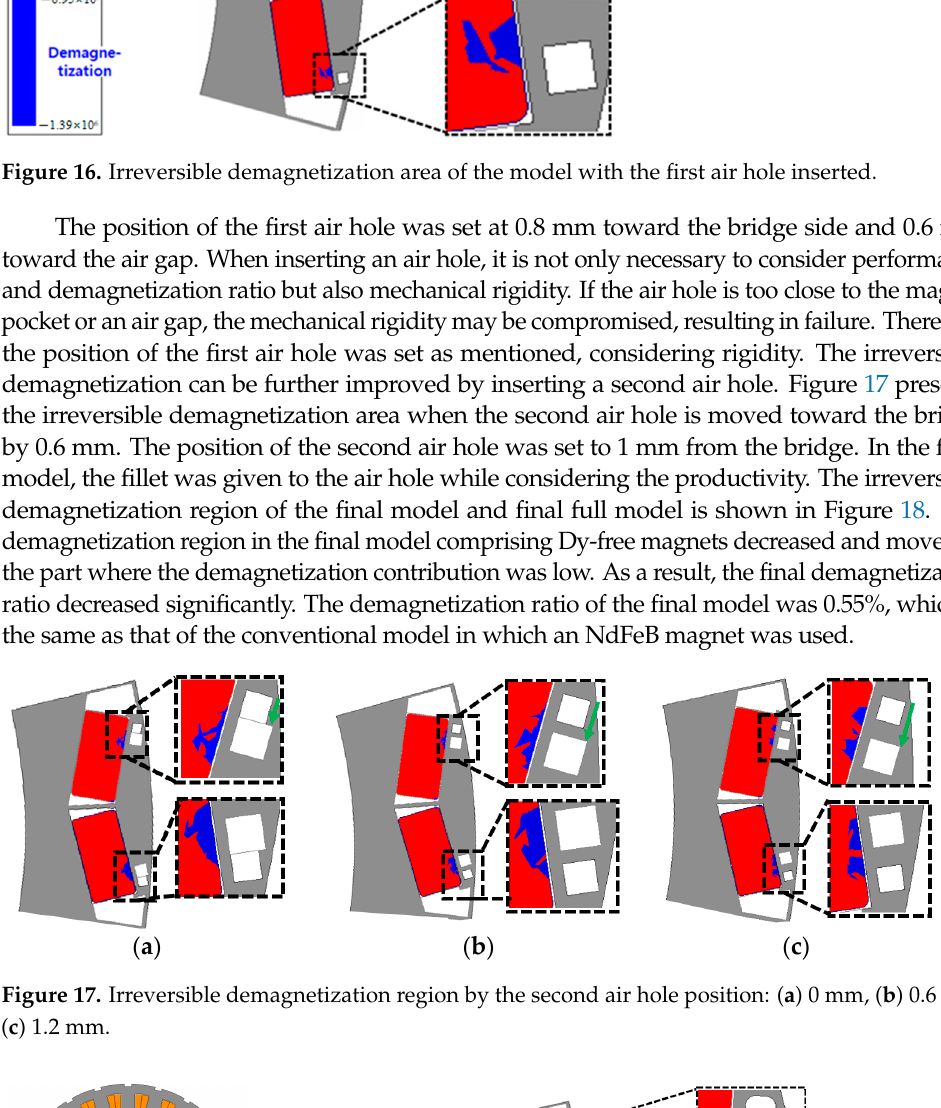
Figure 16. Irreversible demagnetization area of the model with the first air hole inserted.